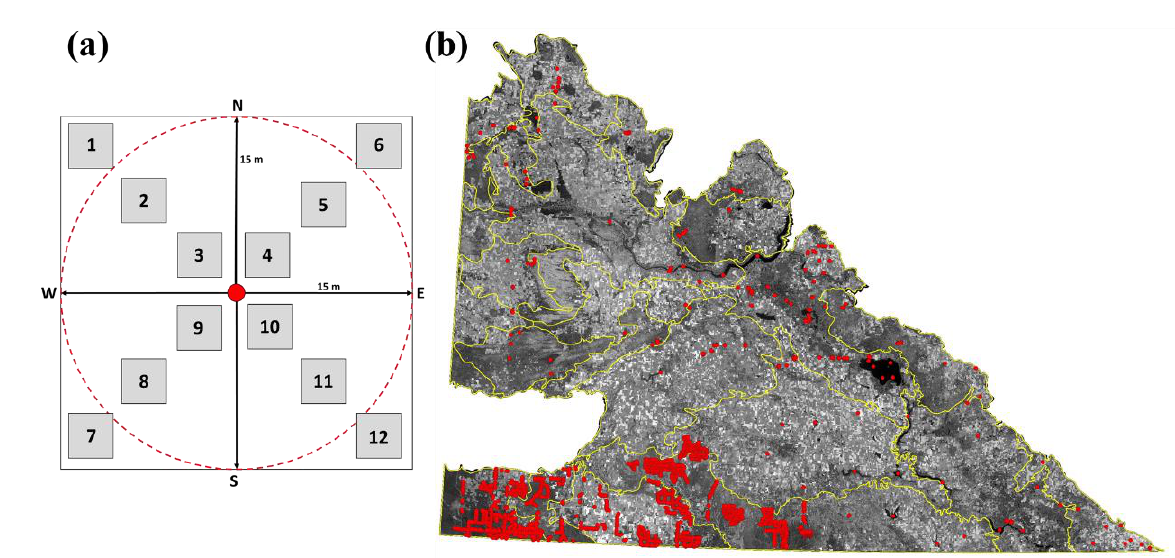
Figure 2. The ground-truthing of PLI during the survey year 2019 and historical field survey data; ( a ) the survey plot designed for grassland identification survey in 2019; ( b ) the field survey spatial coverage (n = 2385) from several PLI field surveys and historical filtered databases.